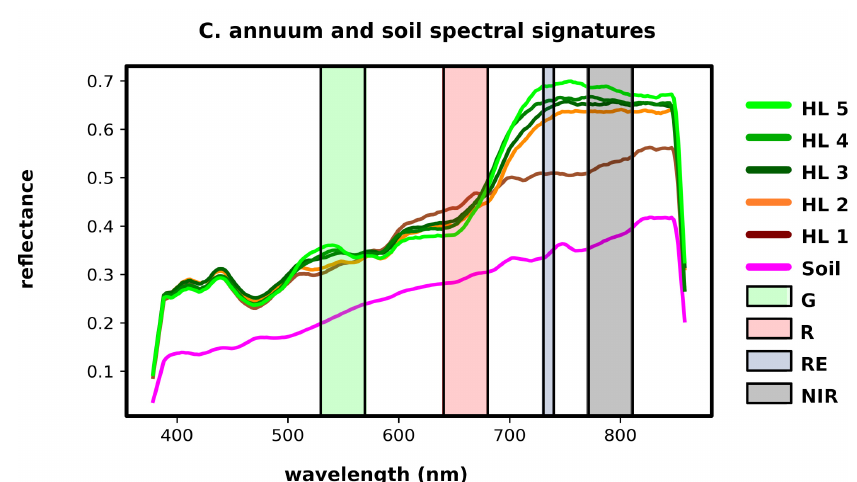
Figure 12. Class average spectral signatures of soil and plants classified at different health levels. Color strips represent band ranges captured by the multispectral